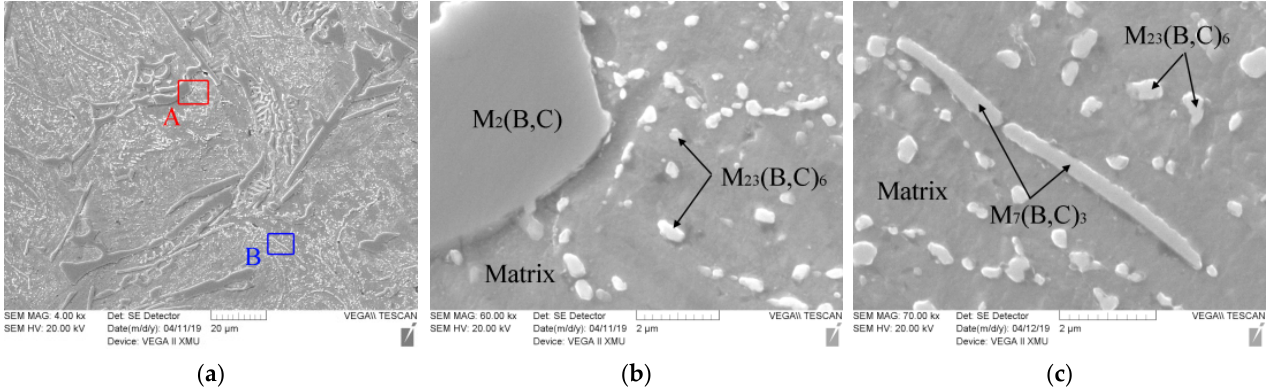
Figure 5. The microstructure analysis of heat-treated boron-bearing stainless steel: ( a ) the heat-treated microstructures; ( b ) displaying the microstructures of A area in ( a ); ( c ) displaying the microstructures of B area in ( a ).